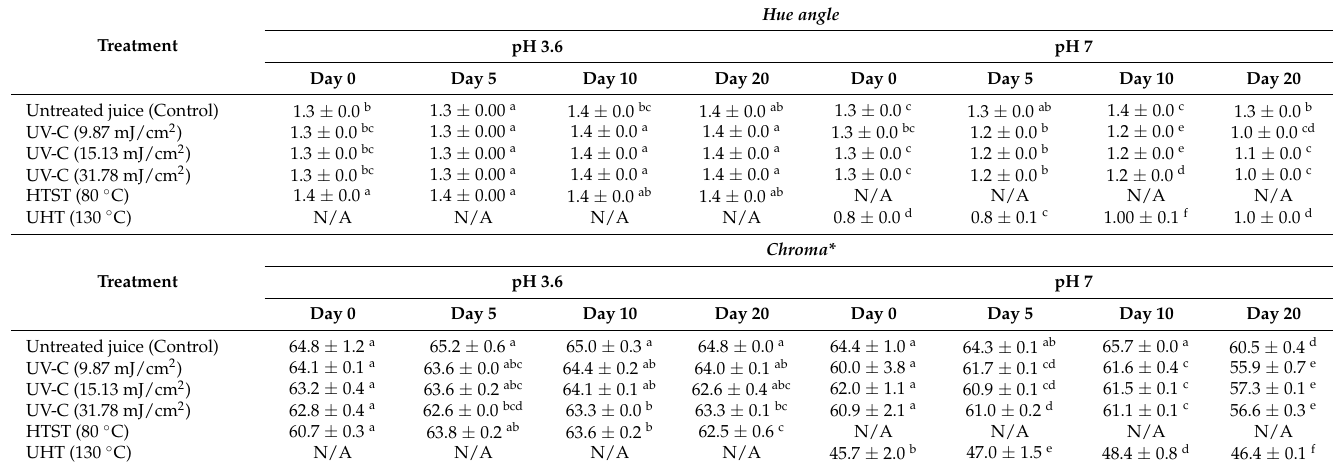
Table 5. Effect of UV-C irradiation and thermal treatment on color parameters ( hue angle and chroma* ) of red prickly pear